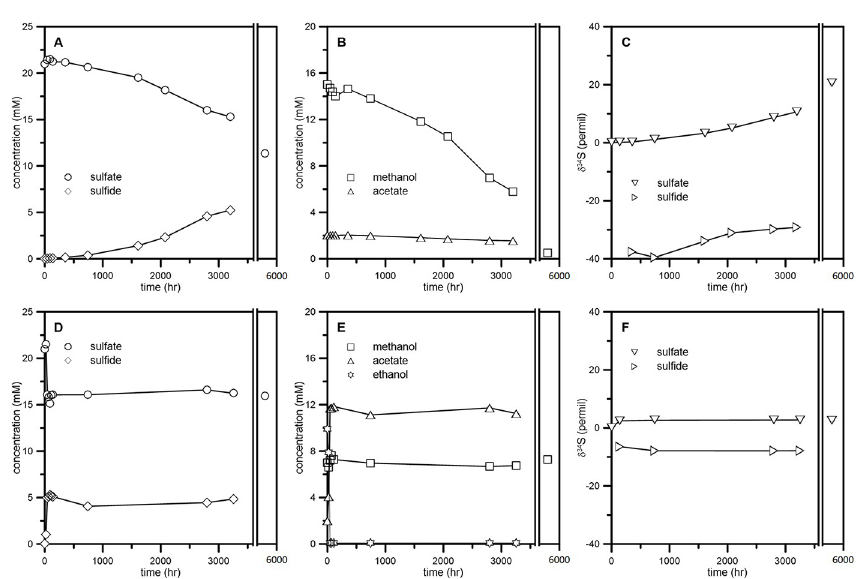
Fig 2. Time evolution of concentrations and sulfur isotope compositions of metabolites during the batch culture containing methanol as a sole electron donor (A-C) and ethanol and methanol as mixed substrates (D-E).